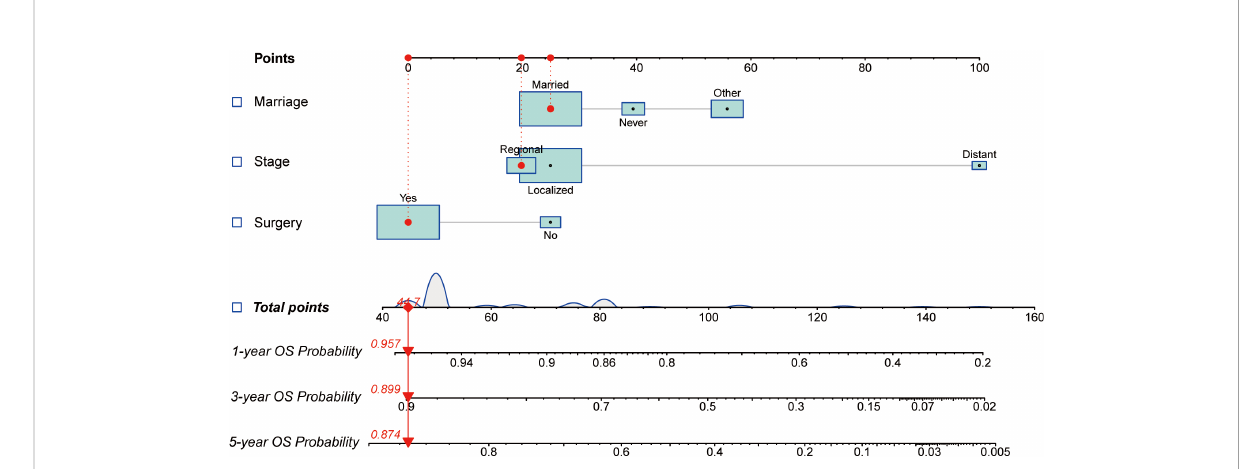
FIGURE 5 The nomogram for predicting 1-year, 3-year, and 5-year OS of patients with penoscrotal